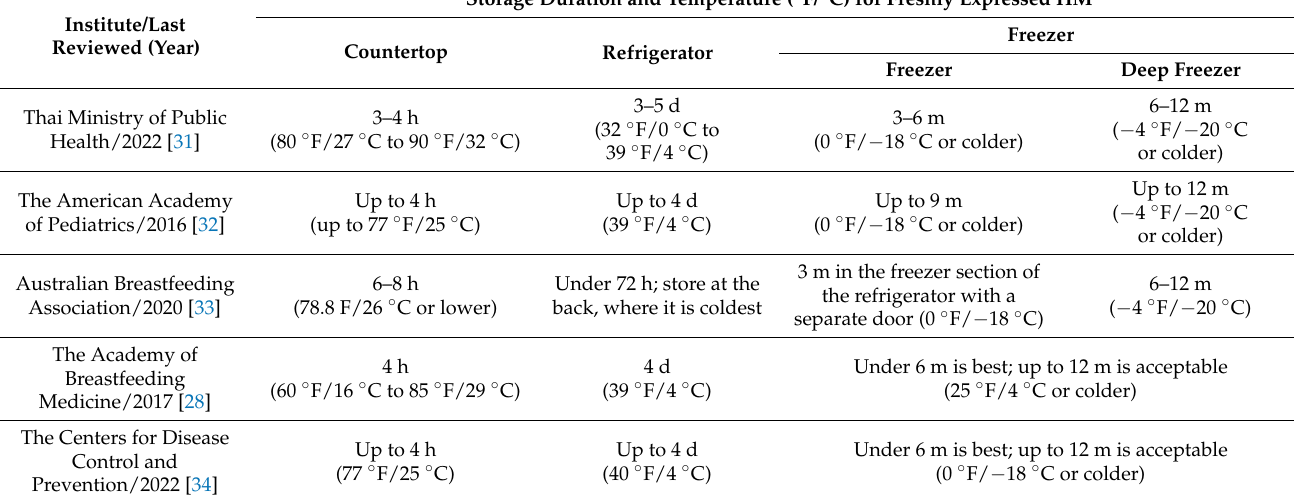
Table 1. Summary of human milk storage